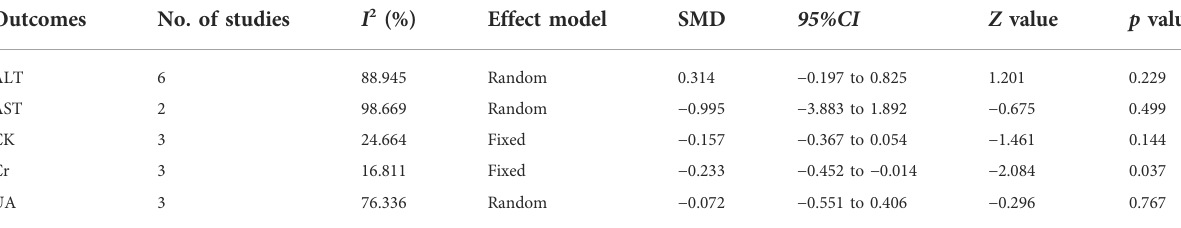
TABLE 3 Meta-analysis of the safety of RYR therapy on the carotid atherosclerosis. Outcomes No. of